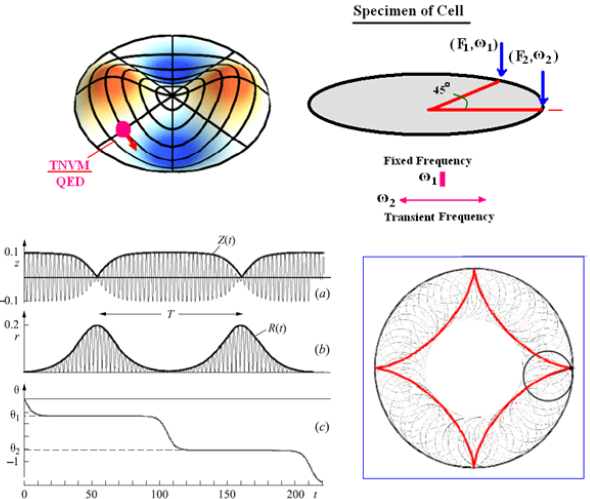
Figure 2. Swinging spring model generated by two excitation forces; ( a ) the amplitude of the springing component and ( b ) the amplitude of the swinging component and ( c ) the angle of swinging